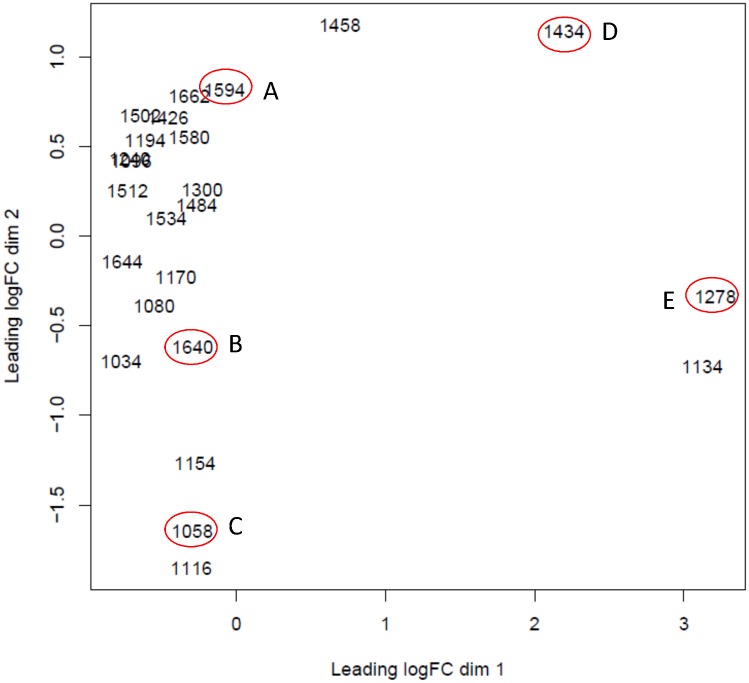
Multidimensional scaling analysis of MSUPRP dataset.Twenty four samples were represented in the main plane (dimension 1 and dimension 2 explained 22.4% and 13.8% respectively) and five distant samples (A, B, C, D, E, marked with ovals) were selected as input samples to generate plasmode datasets.